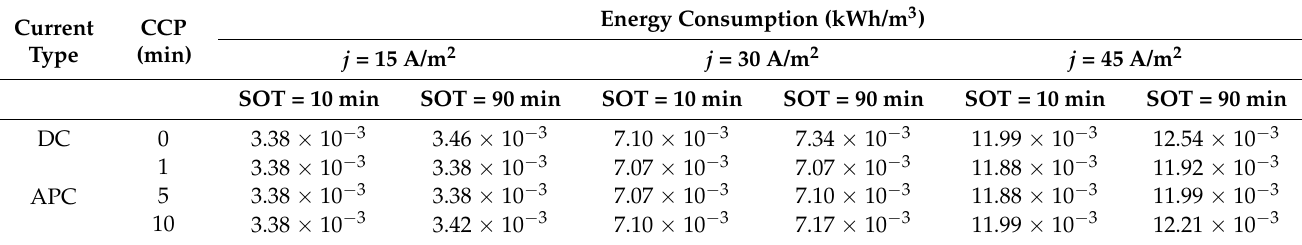
Table 4. Effects of current density and CCP on energy